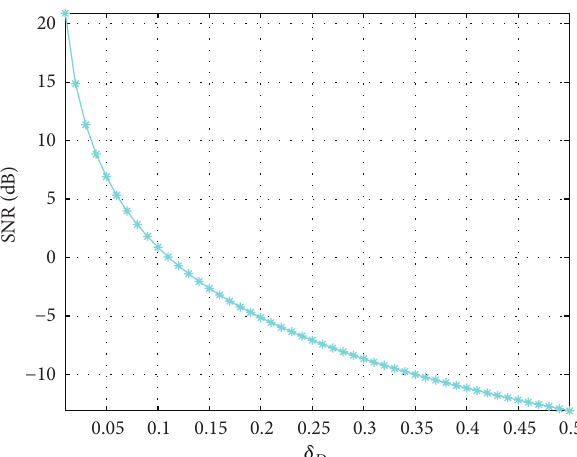
Figure 2: The SRL in the Doppler dimension versus the resolution threshold.